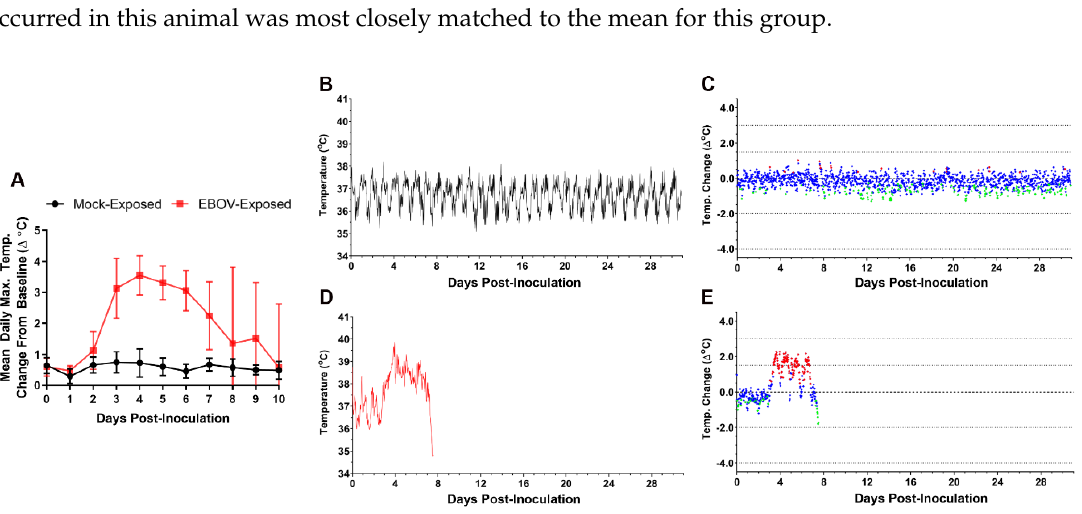
Figure 4. Telemetry-based body temperature changes in mock- vs. EBOV-exposed animals. ( A ) Group mean of daily maximum change from baseline body temperature. Error bars represent SD. X-axis has been truncated to highlight responses occurring from the time of mock or virus exposure events through the acute disease phase. No statistical analyses were performed. Representative mock-exposed animal absolute body temperature ( B ) and change from baseline (running 30-min average) ( C ). Representative EBOV-exposed animal absolute body temperature ( D ) and change from baseline (running 30-min average) ( E ). (C,E) Values −3 SD ( ♦ ) or +3 SD ( ♦ ) from baseline are statistically significant; values < 3 SD ( ♦ ) are not significant.